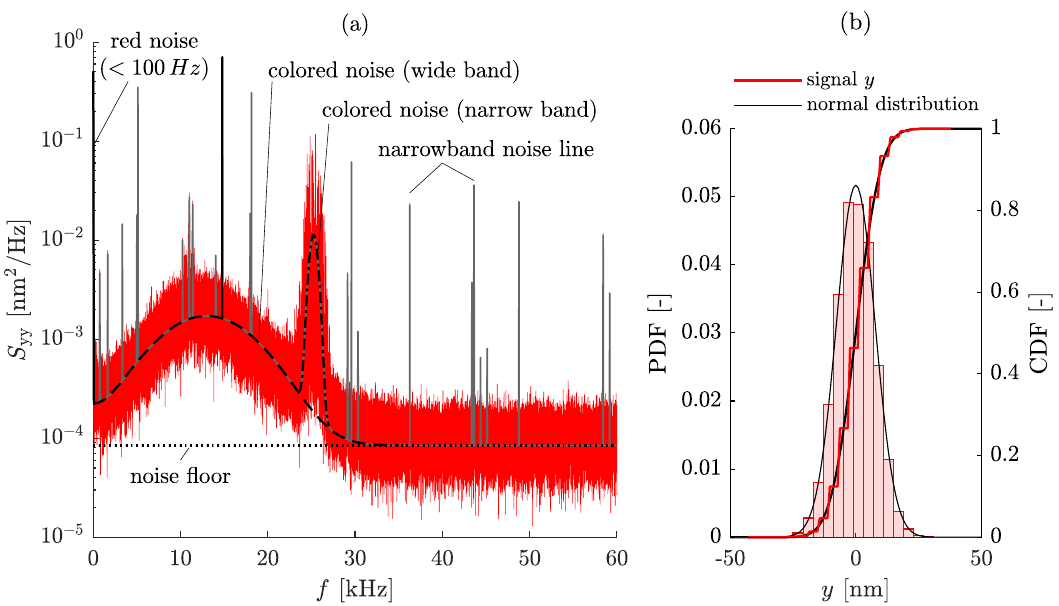
Figure 9. Cap test under shop floor conditions ( MT OFF ): ( a ) spectral density S yy (: = S yy,0 ) of output signal y ( t ) with qualitative indication of noise effects; and ( b ) histogram and cumulative distribution function of signal y ( t ) and for normally distributed values with N ( ¯ y , σ 2 y ) for